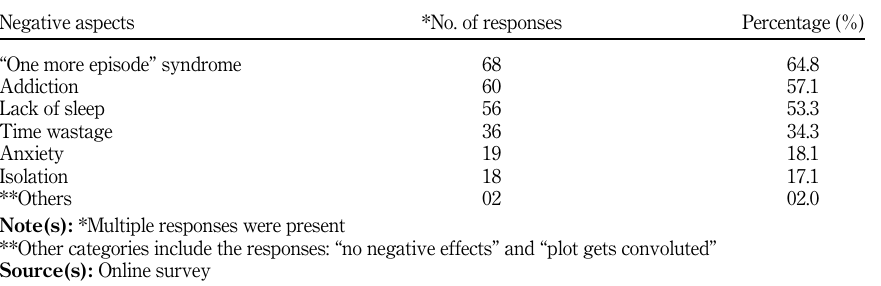
Table 6. Negative attributes